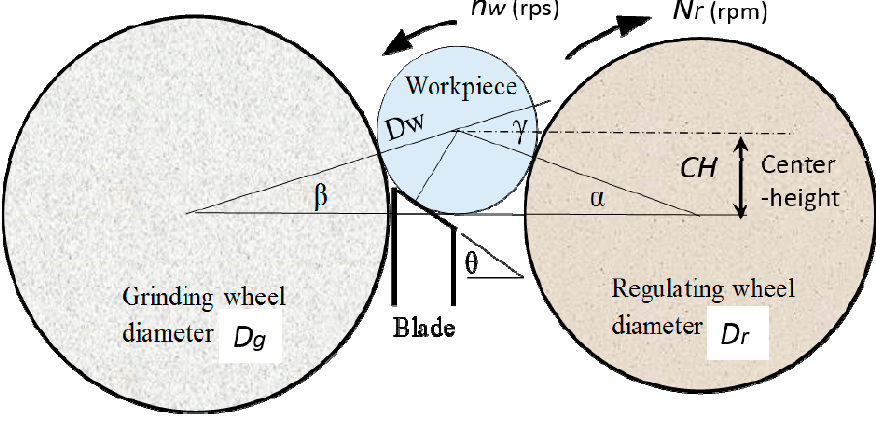
Figure 1. Setup conditions in centerless grinding.